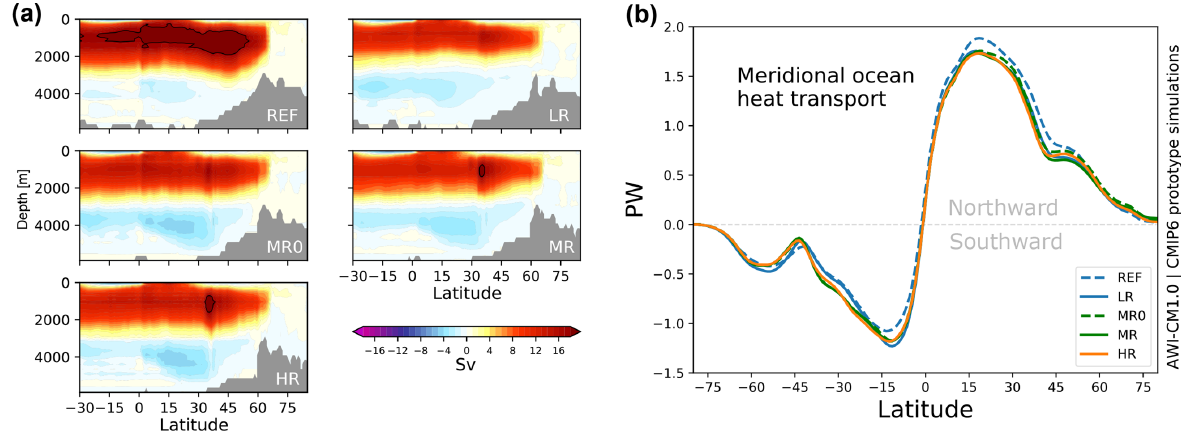
Figure 3. (a) AMOC streamfunction [1Sv = 10 6 m 3 s − 1 ] and (b) meridional ocean heat transport [1PW = 10 15 W] in the five pre-industrial experiments (years 71–100). The black contour in panel (a) denotes the 18Sv